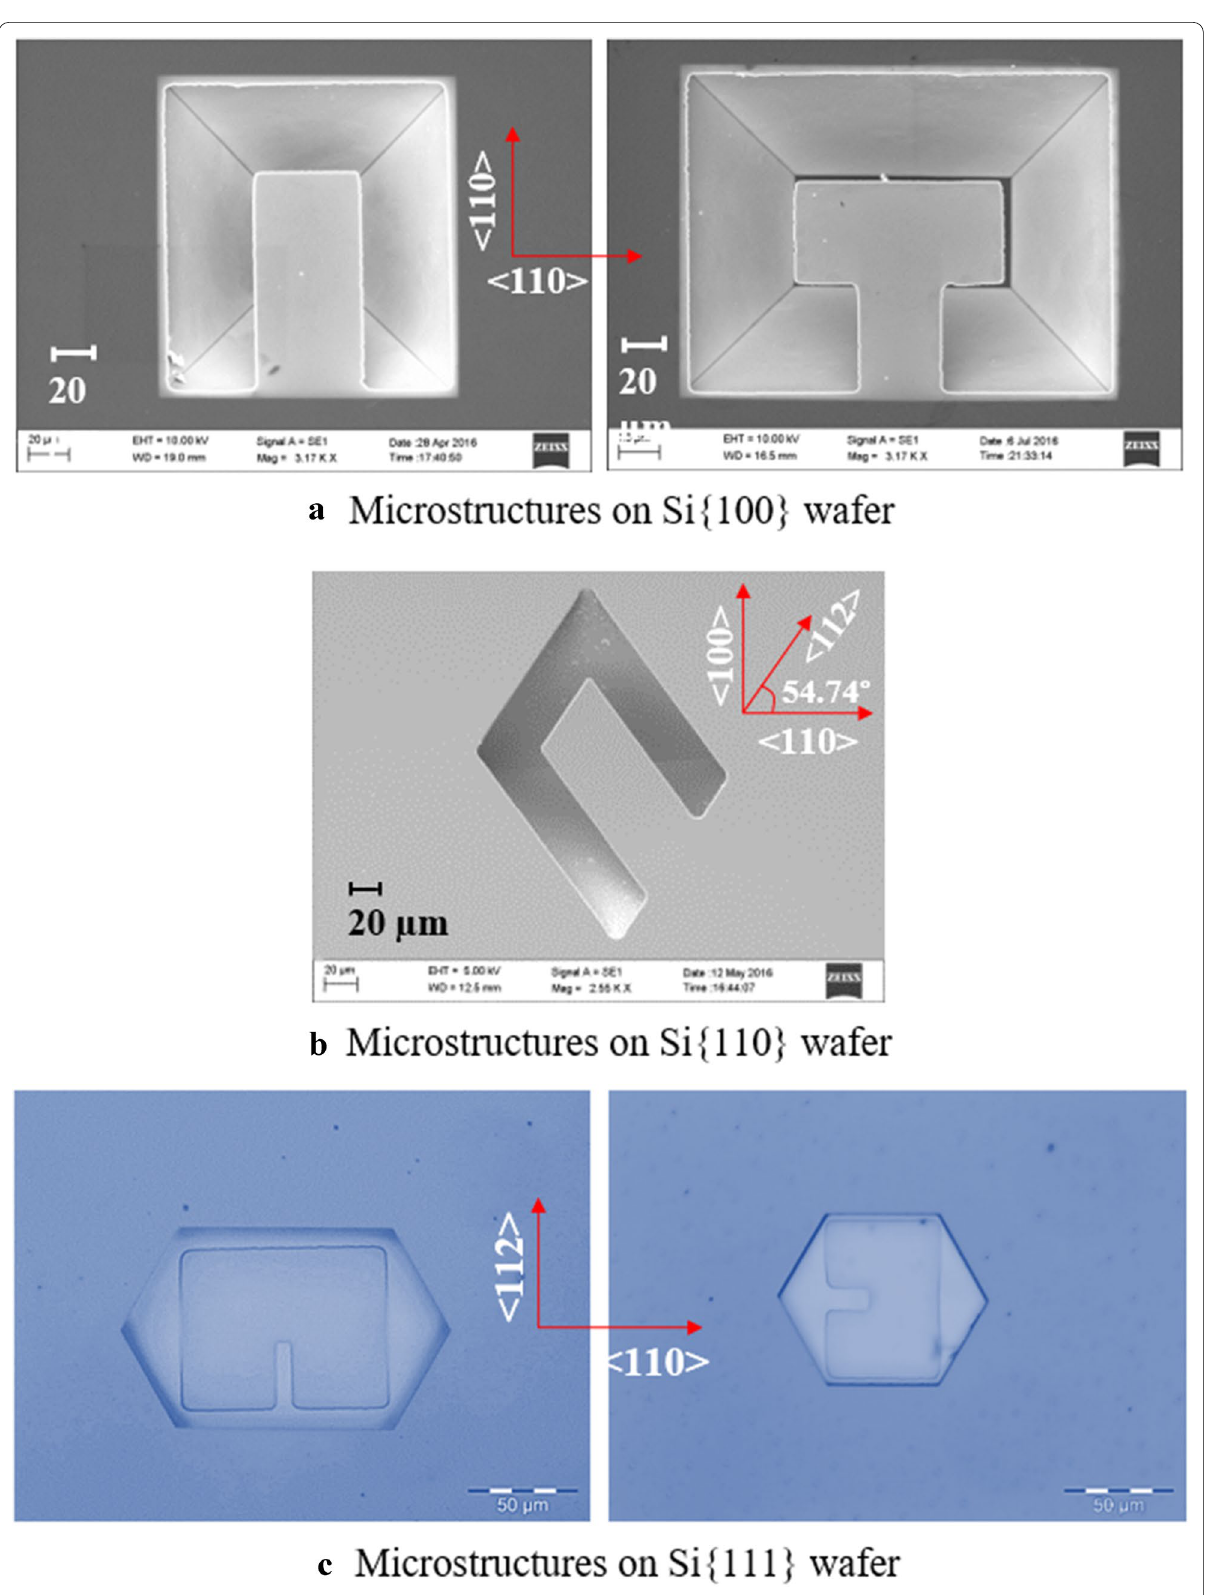
Fig. 66 Freestanding SiO 2 microstructures fabricated on a Si{100}, b Si{110} and c Si{111} wafers in NH 2 OH-added KOH